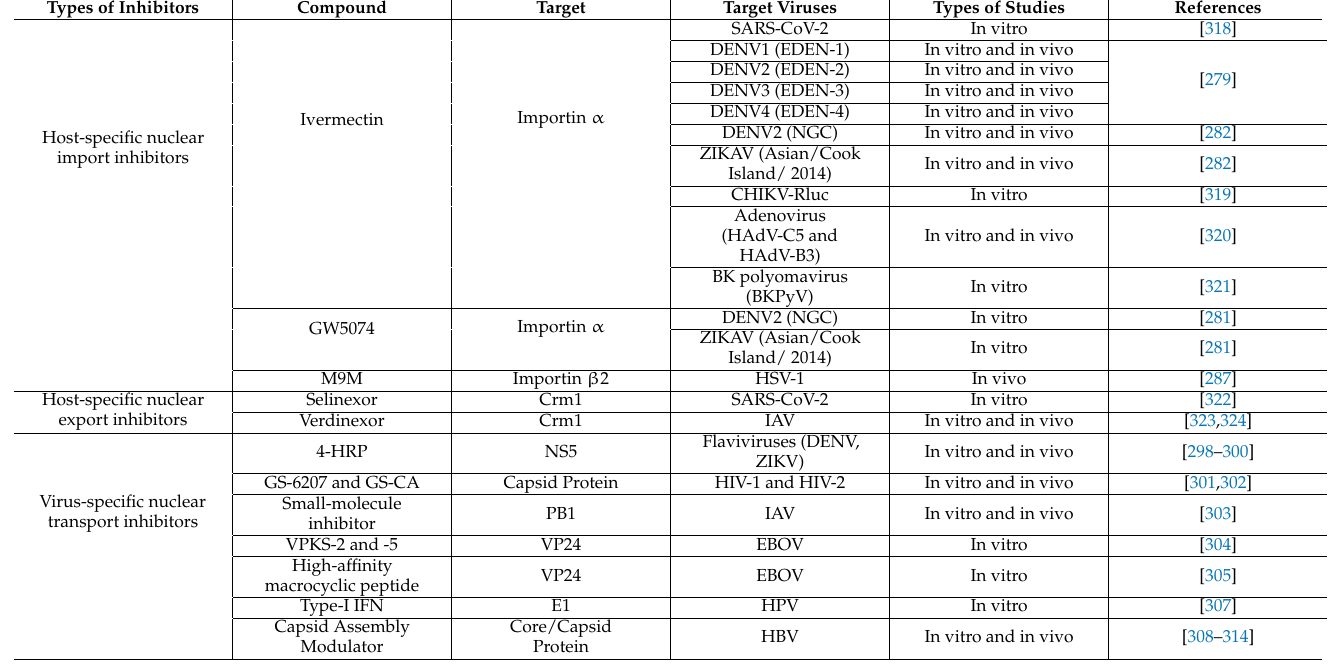
Table 3. Types of Nuclear Transport Inhibitors with Antiviral